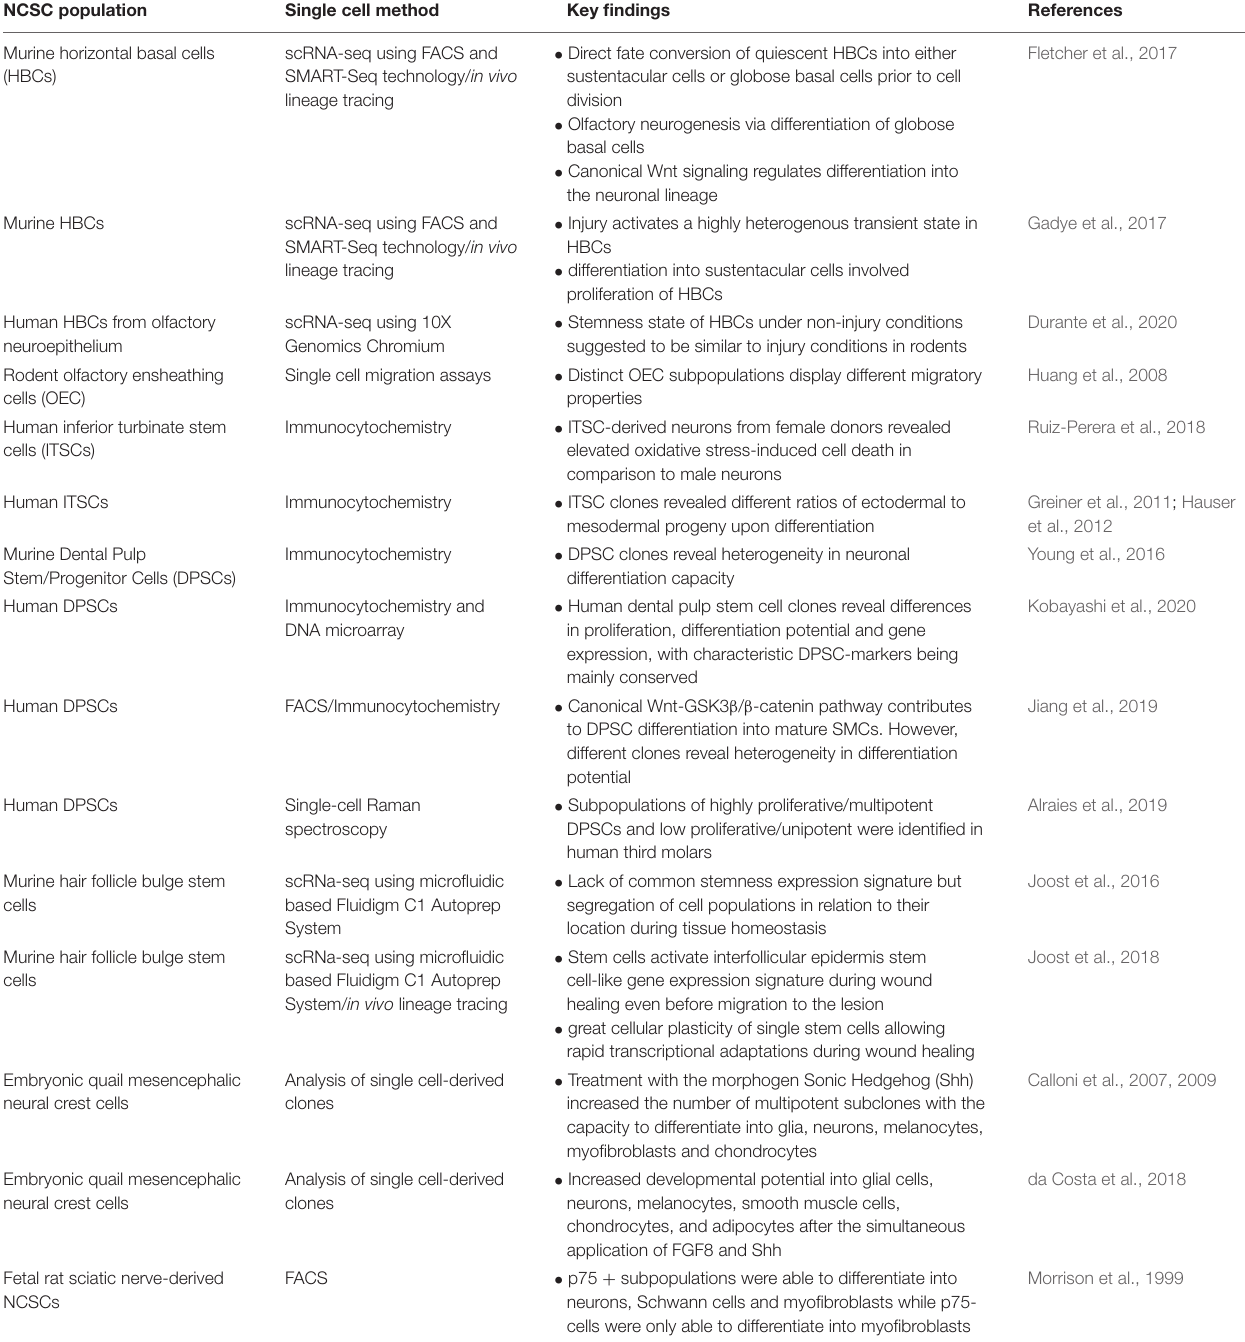
TABLE 1 | Overview of single cell experiments in NCSC